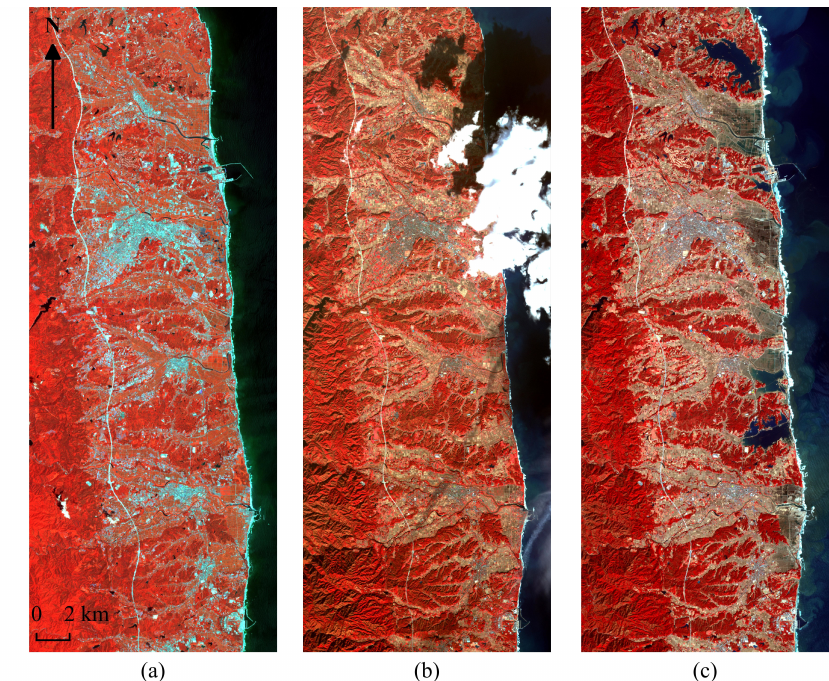
Figure 4. ASTER Images in false colors of the Fukushima prefecture showing an example of season- ality effects in the vegetation and cloud occlusion issues [27]: ( a ) was taken on 10 July 2010, ( b ) on 29 November 2010 and ( c ) on 19 March